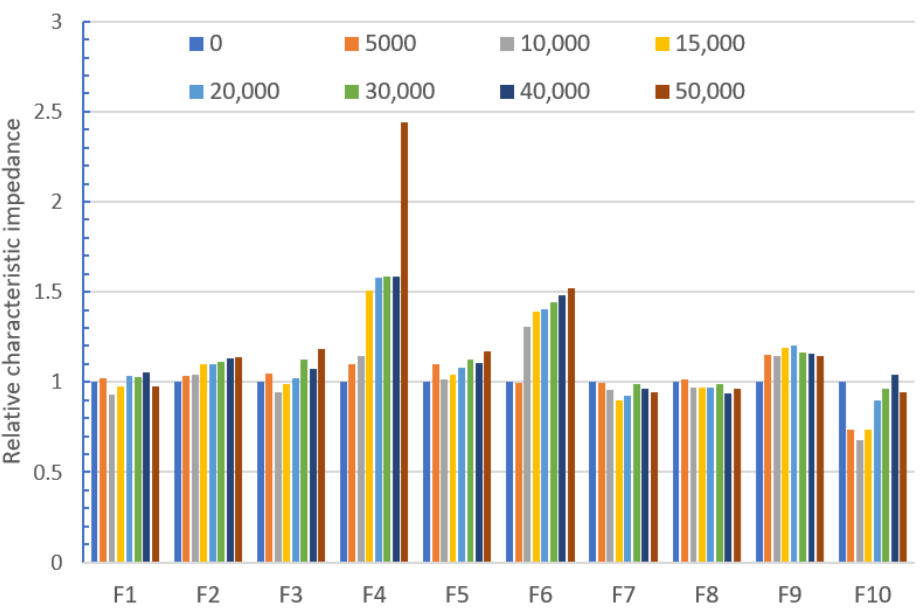
Figure 10. Relative characteristic impedance vs bending cycles for all tested TSLs with a Ponge substrate.